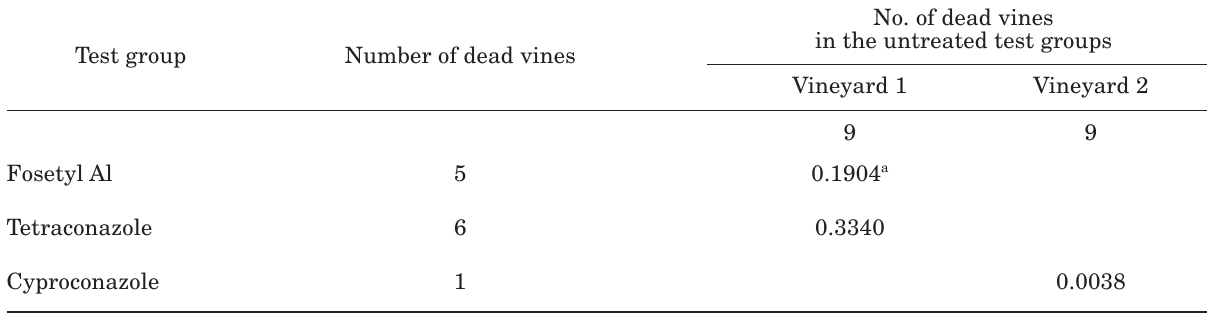
Table 5. Statistical analysis using “set of two (cid:1) r”. The treated test groups in the trunk-injected vineyards were compared with the corresponding untreated test group (trunk-renewal only) according to the frequency of vines in the class “mortality”, as assessed in 2002.